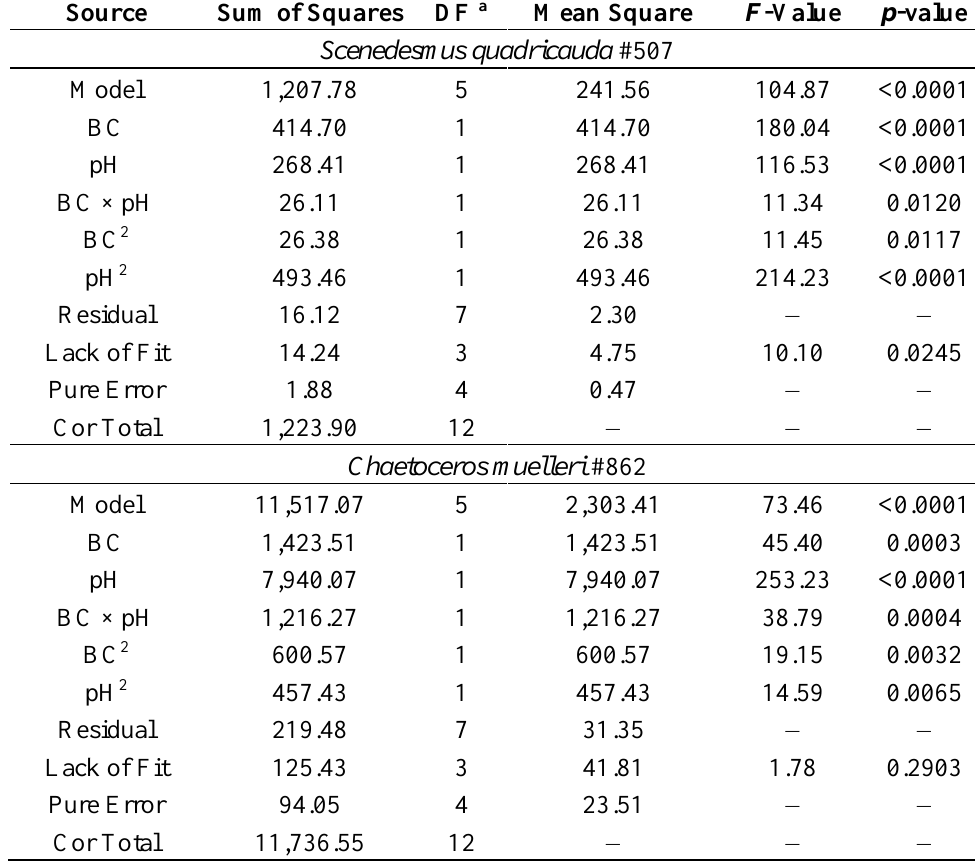
Table 1. Analysis of Variance (ANOVA) for Response Surface Quadratic Model.